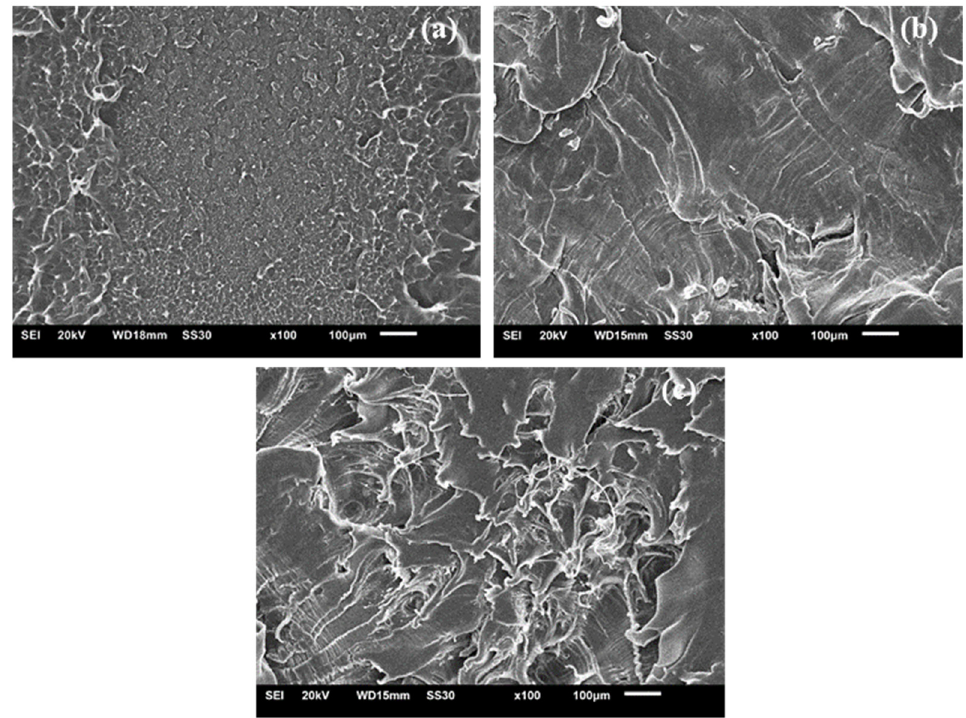
Figure 14. SEM images of crosslinked LLDPE ( a ) 0% peroxide, ( b ) 1% peroxide and ( c ) 2% peroxide. The images obtained of the UHMWPE samples are observed in Figure 15. The neat condition (0% peroxide) exhibited a brittle morphology, characterized by a package of microcable strips [48]. With the addition of peroxide, the predominant ductile material morphology was verified along with some brittle regions [49,50].